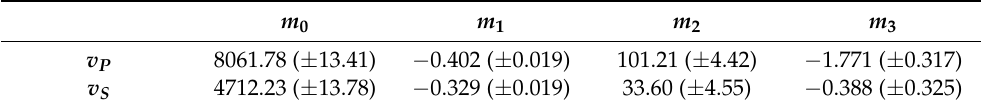
Table 1. Fitting coefficients for Equation